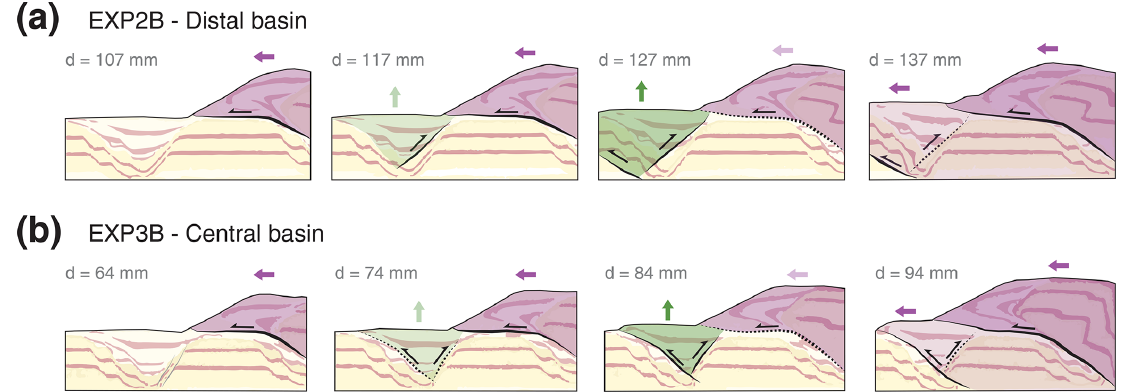
Figure 11. Interpreted sections of selected experiments showing thrust sheet progression and impact on basin inversion. (a) Experiment 2B, distal basin. (b) Experiment 3B, central